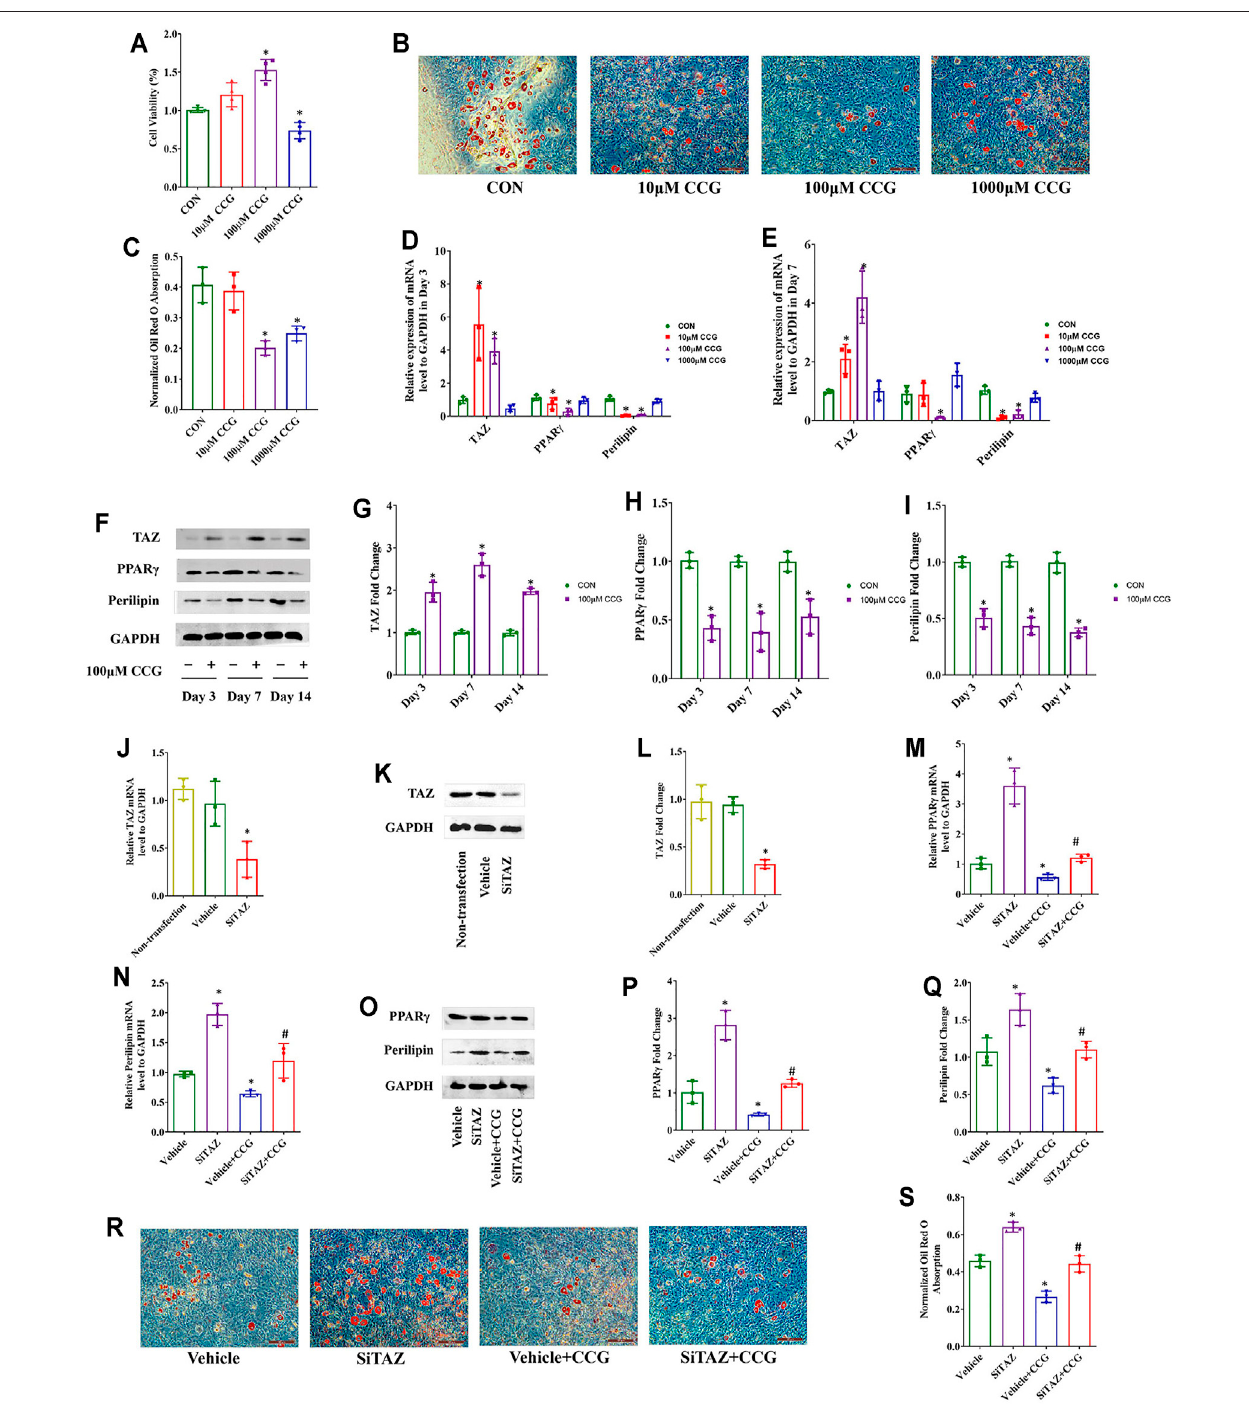
FIGURE 4 | CCG targeted TAZ to reduce adipogenic differentiation of BMSCs in vitro . (A) MTT assays presented cell viabilities after CCG administration during adipogenesis ofBMSCs. (B, C) Representative images of Oil Red O staining re fl ected thelipid droplets. Scale bar: 100 μ m. (D,E) Relative mRNA levels of TAZ, PPAR γ , and perilipin to GAPDH were presented in Day 3 and Day 7 in the absence or presence of CCG during adipogenesis. (F – I) Relative protein levels of TAZ, PPAR γ , and perilipin to GAPDH were presented in Day 3, in Day 7, and in Day 14 after the treatment. * p < 0.05 vs. the control group. (J – L) Relative mRNA and protein levels to GAPDH of TAZ were signi fi cantly knocked down by the SiTAZ plasmid during adipogenesis. (M – Q) SiTAZ discounted the CCG induced up-expression of TAZ and down-expressionofPPAR γ andperilipinatDay3afterthetreatment. (R,S) RepresentativeimagesofOilRedOstainingshowedthelipiddropletsindifferentgroups.Bar graphsshowed themeans ± SDfromthree independent experiments. Scale bar:100 μ m (n (cid:1) 3)* p < 0.05 vs.theVehiclegroup;# p < 0.05 vs.theVehicle +CCG group.